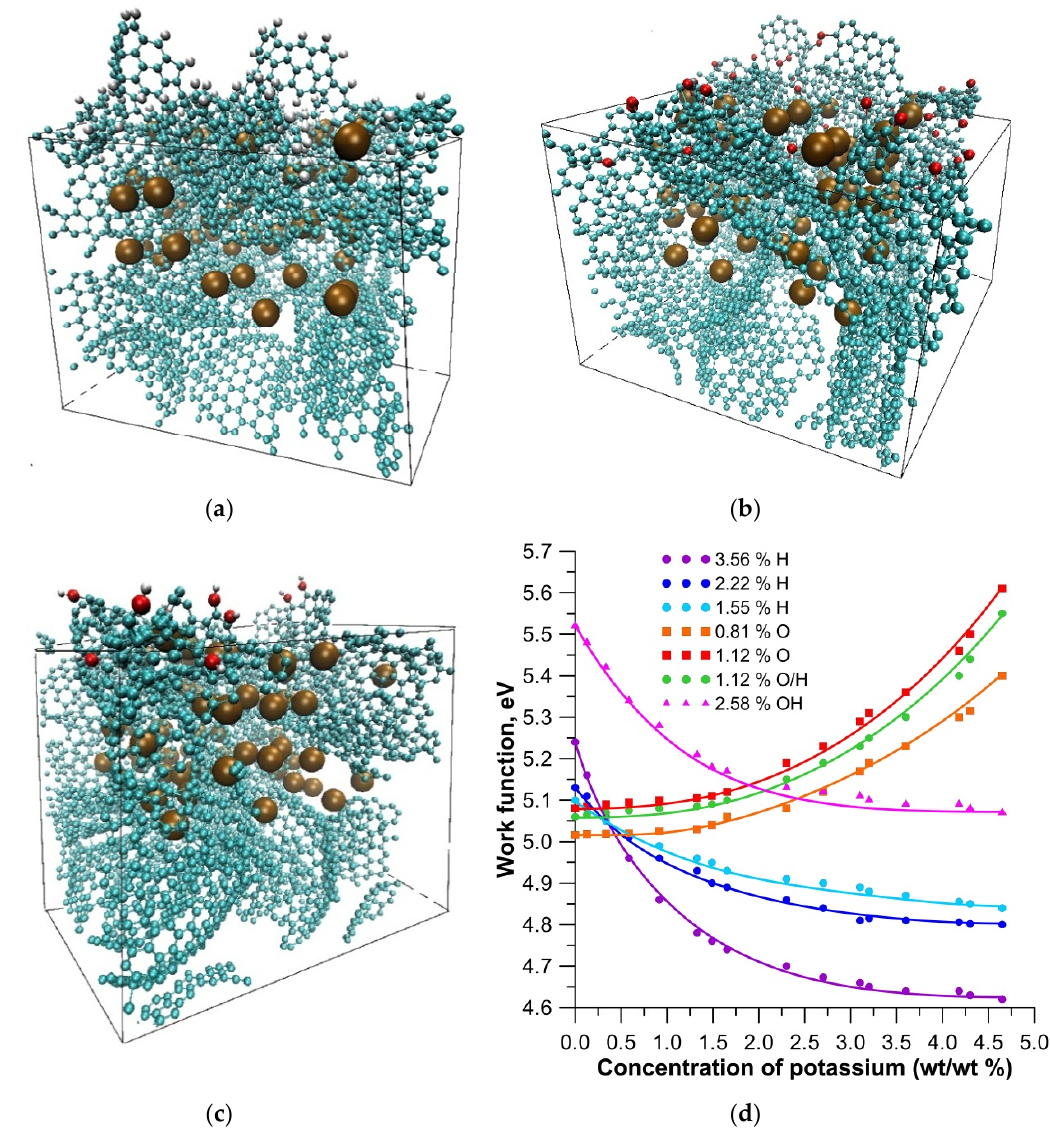
Figure 3. The atomic structure and the work function of a nanocarbon porous film with different types of impurity atoms: ( a ) modification by hydrogen atoms (3.56%); ( b ) modification by oxygen atoms (0.81%); ( c ) modification by OH groups (2.58%); ( d ) a graph of the change in the work function with an increase in the mass fraction of potassium at different concentrations of impurity atoms.